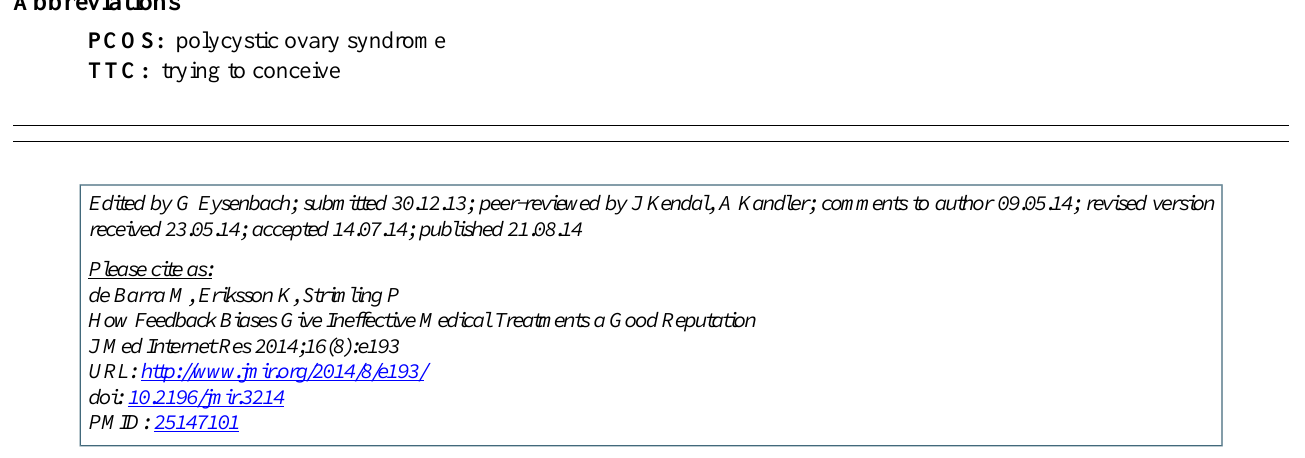
PCOS: polycystic ovary